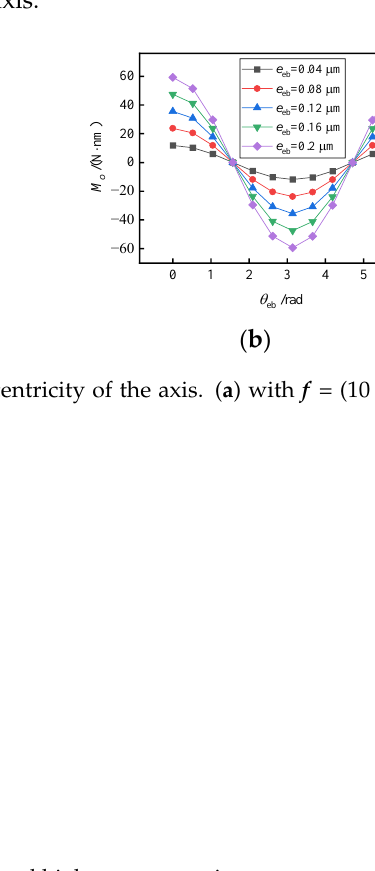
Figure 16. Schematic position of the rotor and high pressure region on a cross-section.